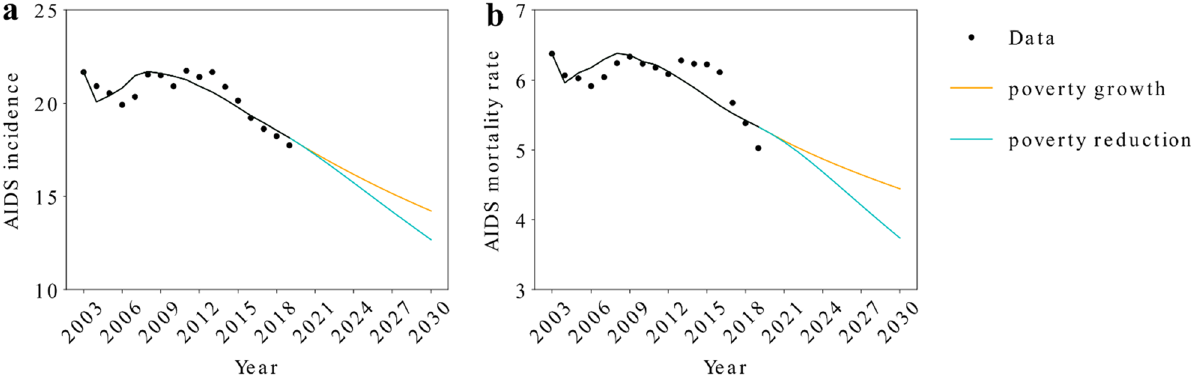
Figure 5. HIV/AIDS incidence and mortality rate under different scenarios of poverty between 2003 and